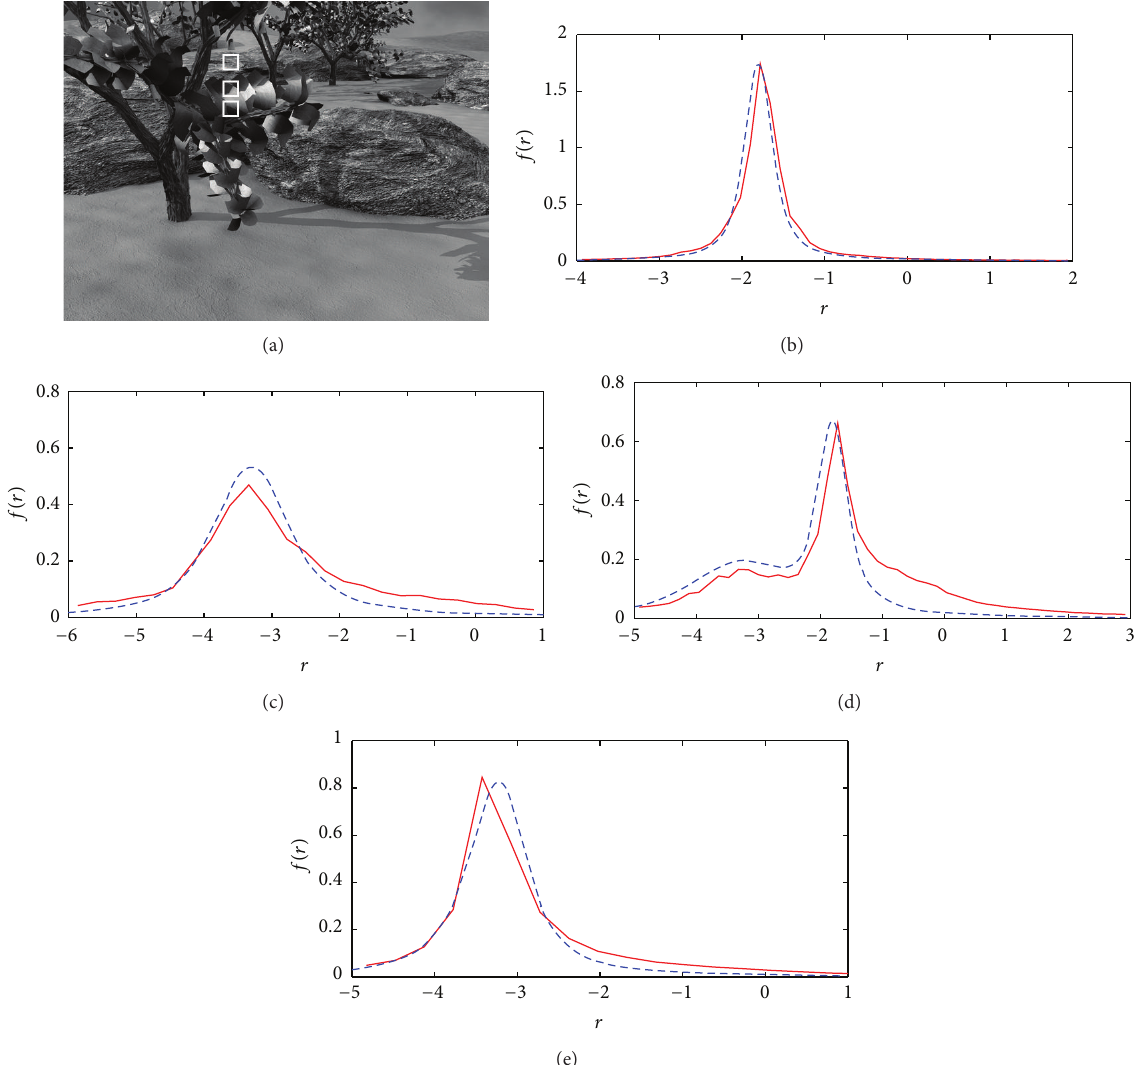
Figure 13: (a) A sample frame of the Grove2 image sequence. (b) and (c) Theoretical (dashed) and measured (solid) pdf of 𝑟 for two different patches on two different objects highlighted by white rectangles on the sample frame. (d) and (e) Joint pdf of 𝑟 values for two patches: (d) of two different objects and (e) of the same